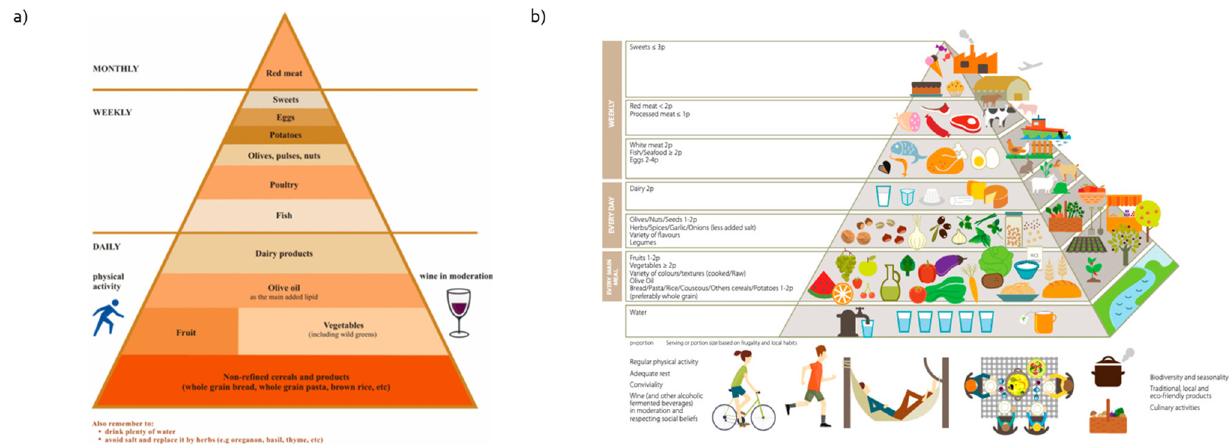
Figure 1. ( a ) The traditional Mediterranean diet pyramid [27] and ( b ) the sustainable Mediterranean diet pyramid